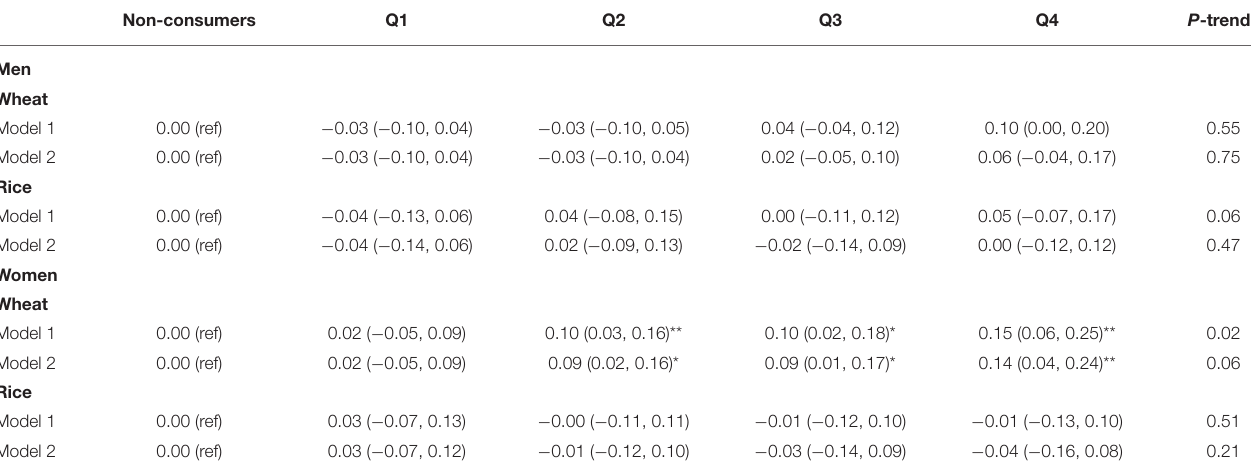
TABLE 2 | Regression coefficients (95% CI) of body mass index (BMI) according to the level of intake of wheat and rice among Chinese adults, CHNS ac